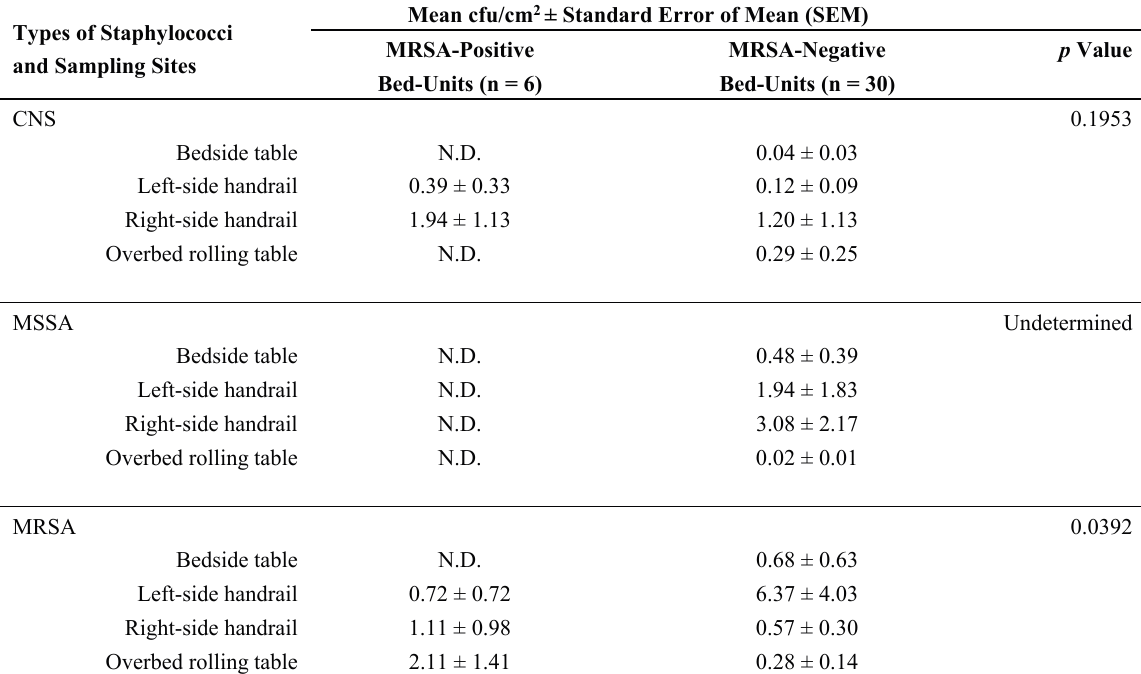
Table 2. A comparison of the concentrations and types of staphylococcal bacteria recovered from the bedside surfaces of bed-units occupied by MRSA-positive and MRSA-negative patients at 08:00